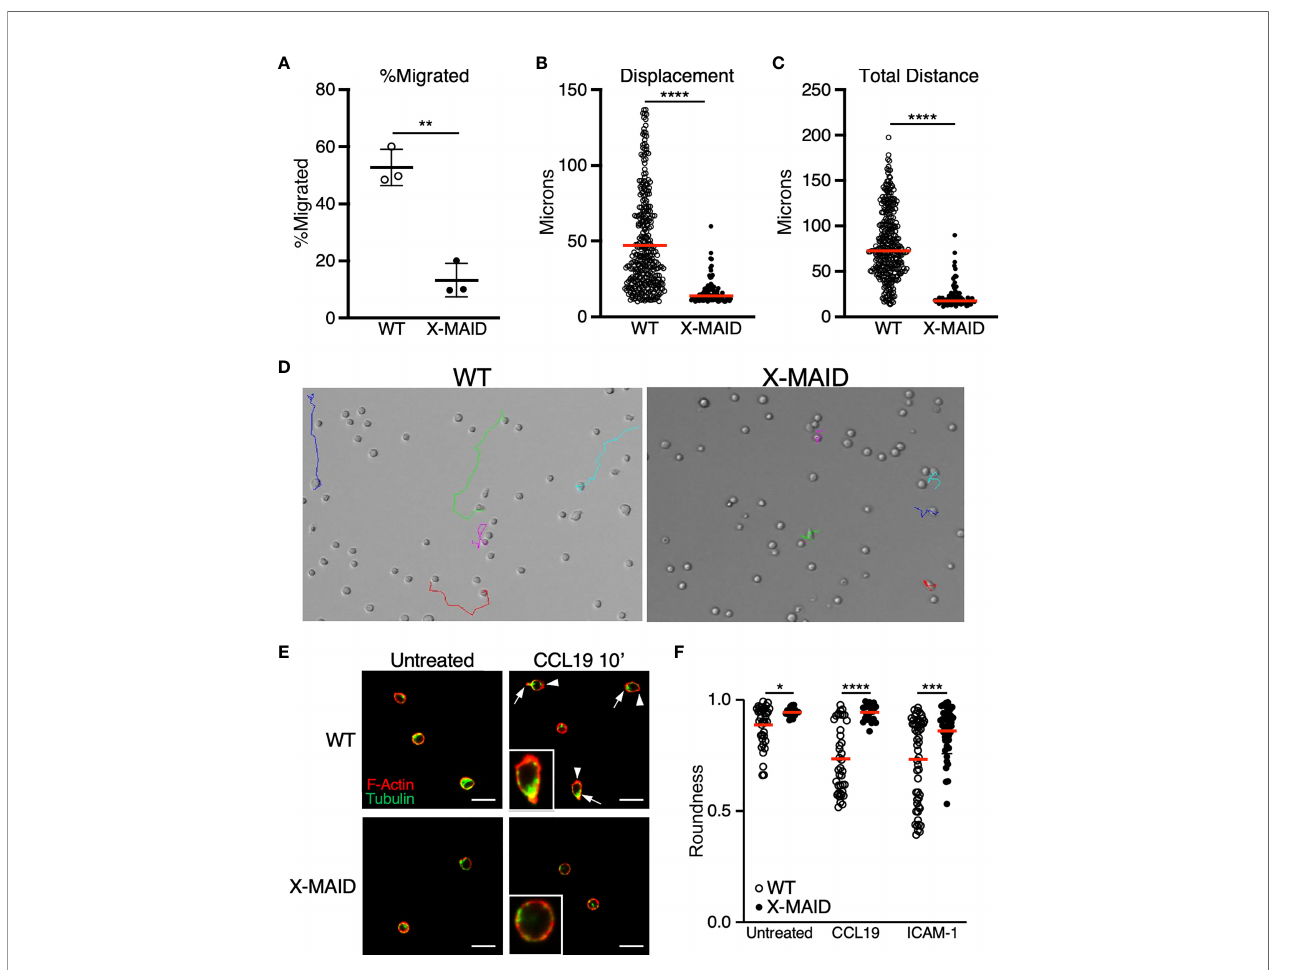
FIGURE 7 | Reduced migratory capability is associated with lack of polarization in X-MAID T cells. (A – D) WT or X-MAID CD4 SP thymocytes were placed on ICAM-1 coated glass surfaces and imaged live using DIC optics every 30 seconds for 10 minutes. Cells were tracked using the manual tracking plugin on ImageJ. (A) % migrated was calculated as any cell moving more than 10 m m and remaining in view for the entirety of the movie. Each point represents a fi eld of at least 100 cells. Data represent means ± StDev. (B) Displacement and (C) Total distance traveled were calculated from fi rst frame to fi nal frame. (D) Representative images of the fi nal frame with colored tracks from individual cells. (E) CD4 SP thymocytes were left untreated or stimulated with 100ng/ml CCL19 for 10 minutes, then fi xed to a poly-L coated surface and stained for F-actin and tubulin to visualize actin leading edge (arrowheads) and tubulin-rich uropods (arrows). Representative images are shown for each condition, insets show higher magni fi cation views of typical cells. Scale bars = 20 m m (F) Images like those in (D, E) were used to measure roundness of cells using ImageJ software as detailed in the Materials and Methods. Means ± StDev are shown. (A – D) show data from one experiment (performed using cells pooled from 3-5 mice). This experiment was done twice with separate pools of mice, with similar outcomes. The data in (E, F) are pooled from two separate experiments done on different days, with each experiment using cells pooled from 3-5 mice. Data from the two experiments were in agreement, so were pooled for presentation. In (A) , each point represents one fi eld of cells; In (B, C, F) each point represents a single cell. Red bars in (B, C, F) represent means. Statistics for all panels were calculated using a Student ’ s t test, *p < 0.05, **p < 0.01, ***p < 0.005, ****p <